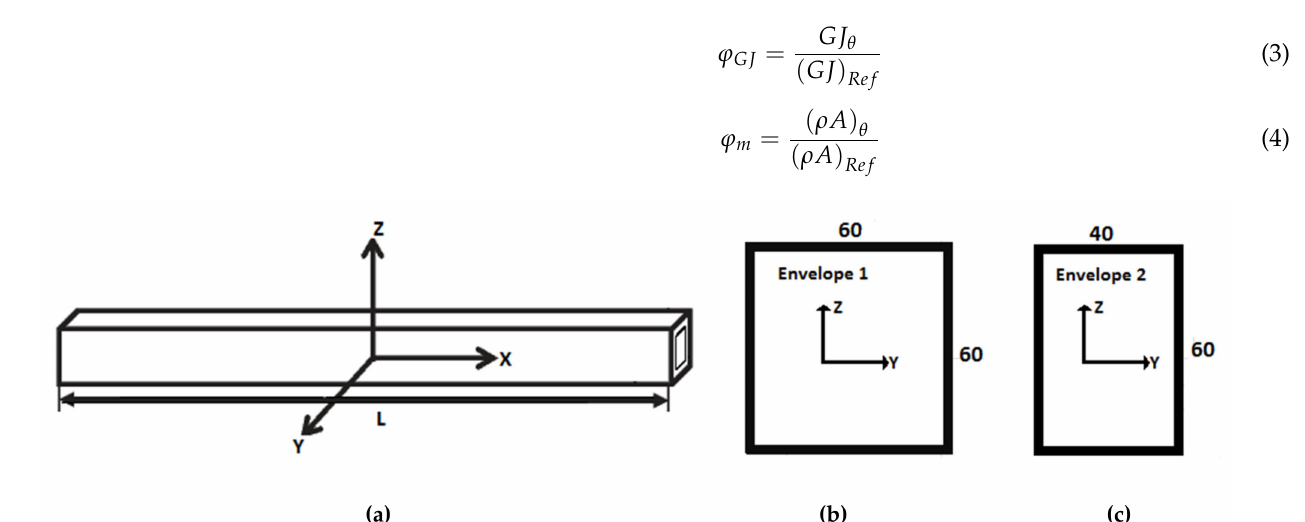
Figure 1. ( a ) Prismatic Beam, ( b ) square envelope, and ( c ) rectangular envelope. Note: all dimensions are in